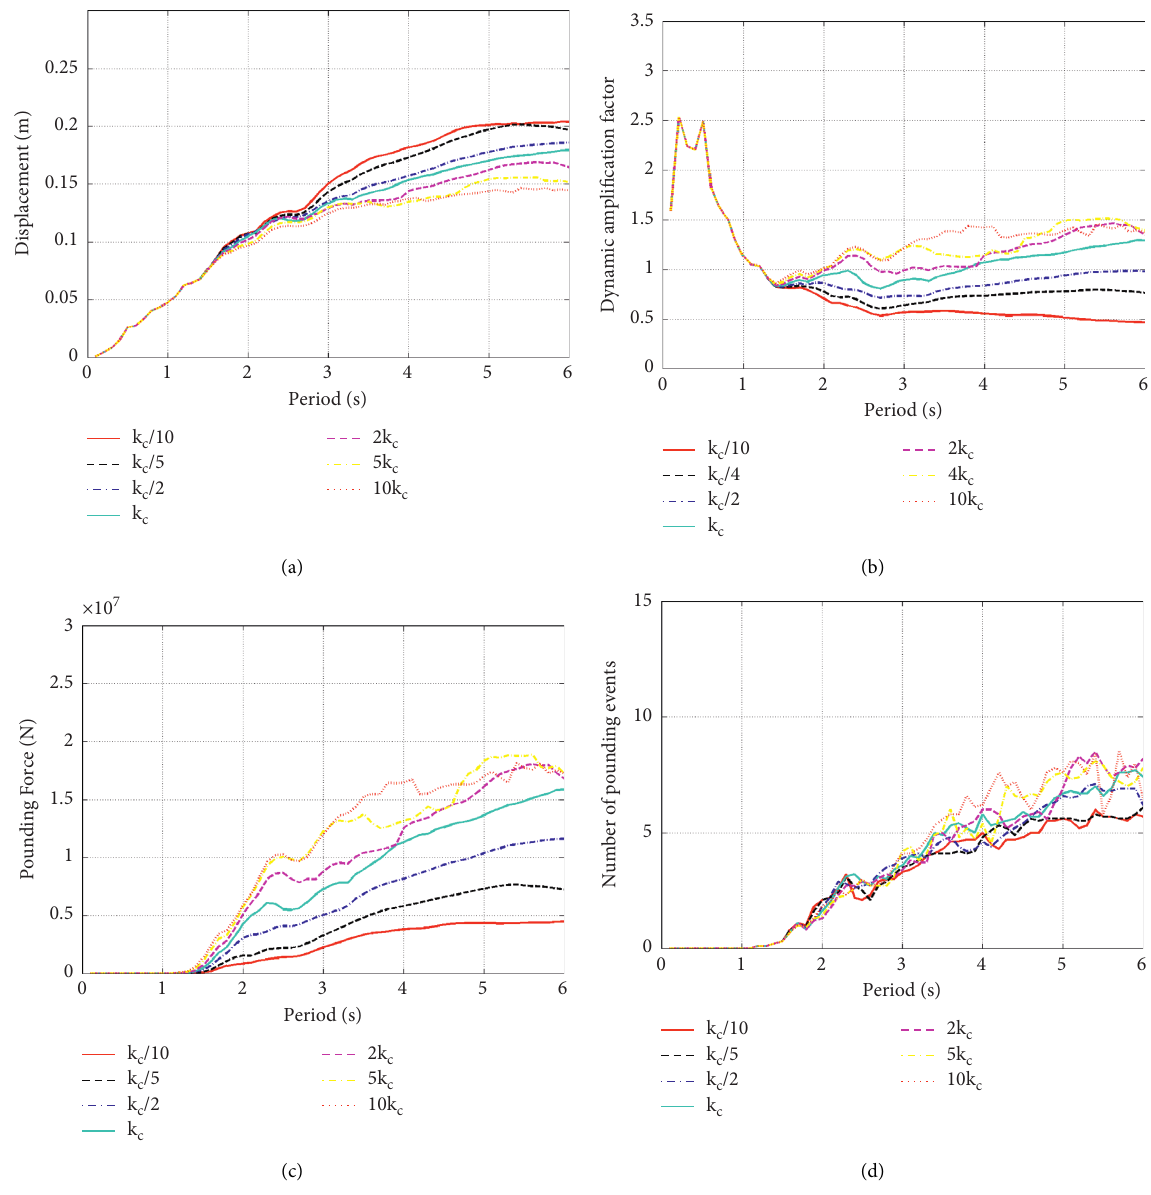
Figure 13: Average spectrum analysis results for different pounding stiffness constants. (a) Displacement spectrum. (b) Dynamic amplification factor spectrum. (c) Pounding force spectrum. (d) Number of pounding event response